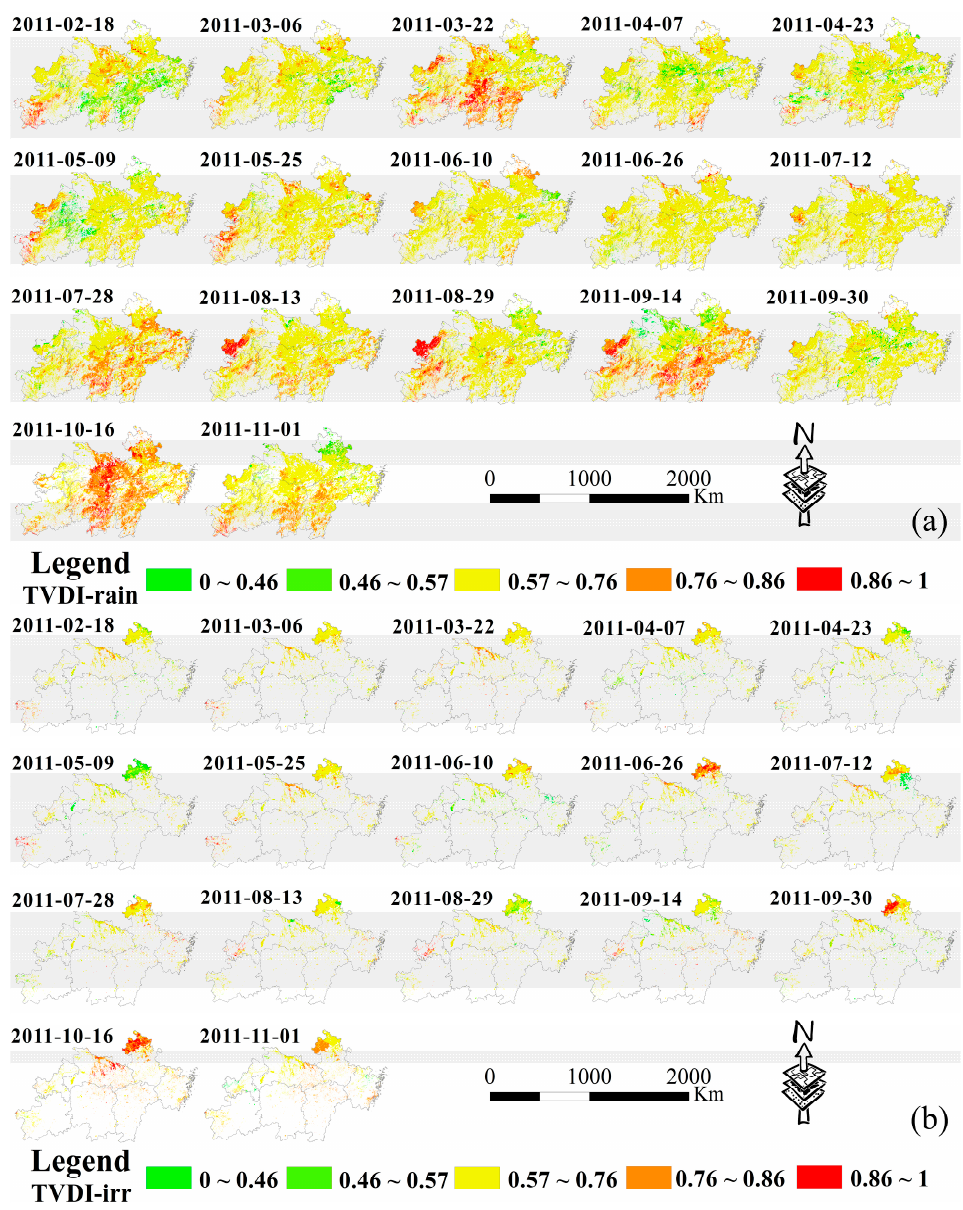
Figure 10. Spatial distribution of the Temperature Vegetation Drought Index (TVDI) in the middle and lower reaches of the Yangtze River in China in 2011, with a temporal resolution of 16 days. The images without crop growth in January and December were removed. ( a ) The TVDI of rain-fed arable land (TVDI-rain). ( b ) The TVDI of irrigated arable land (TVDI-irr).